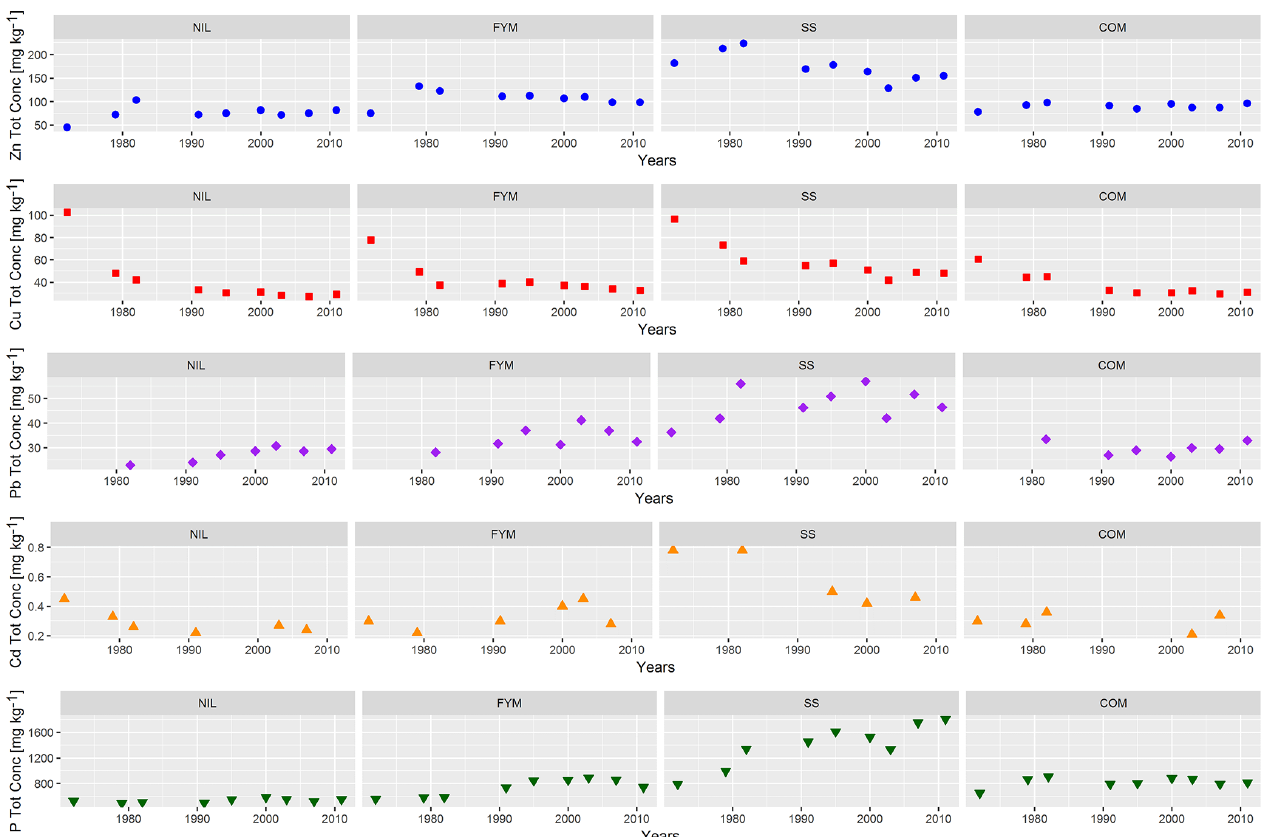
Figure 4. Total concentration time trends of Zn, Cu, Pb, Cd and P in ZOFE topsoil (20cm) for the treatments NIL, FYM, SS and